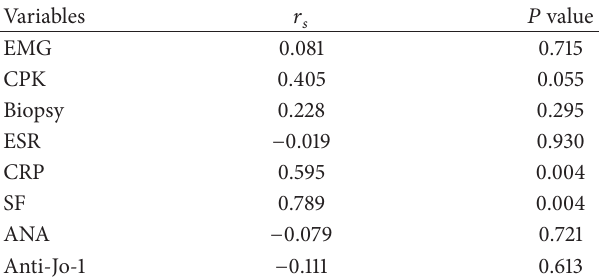
Table 3: Correlation between IL-6 and laboratory markers in patients with DM.